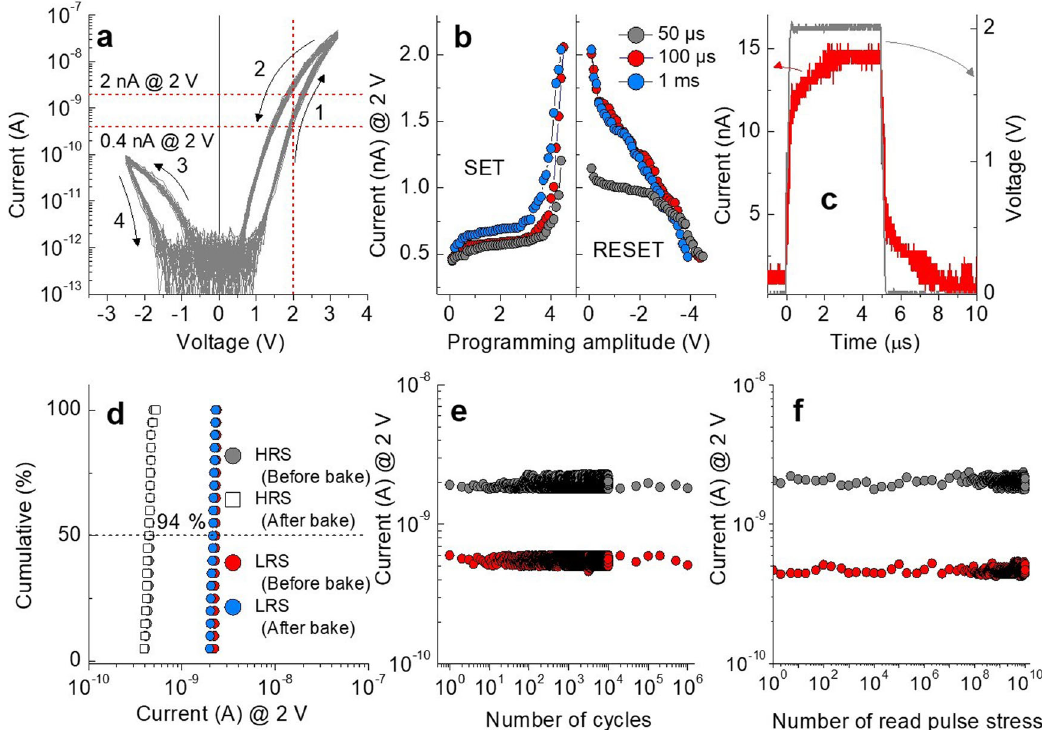
Fig. 1 Electrical characterization of the unit self-rectifying resistive memory cell (SRMC). a DC I – V characteristics of 30 SRMCs. Arrows